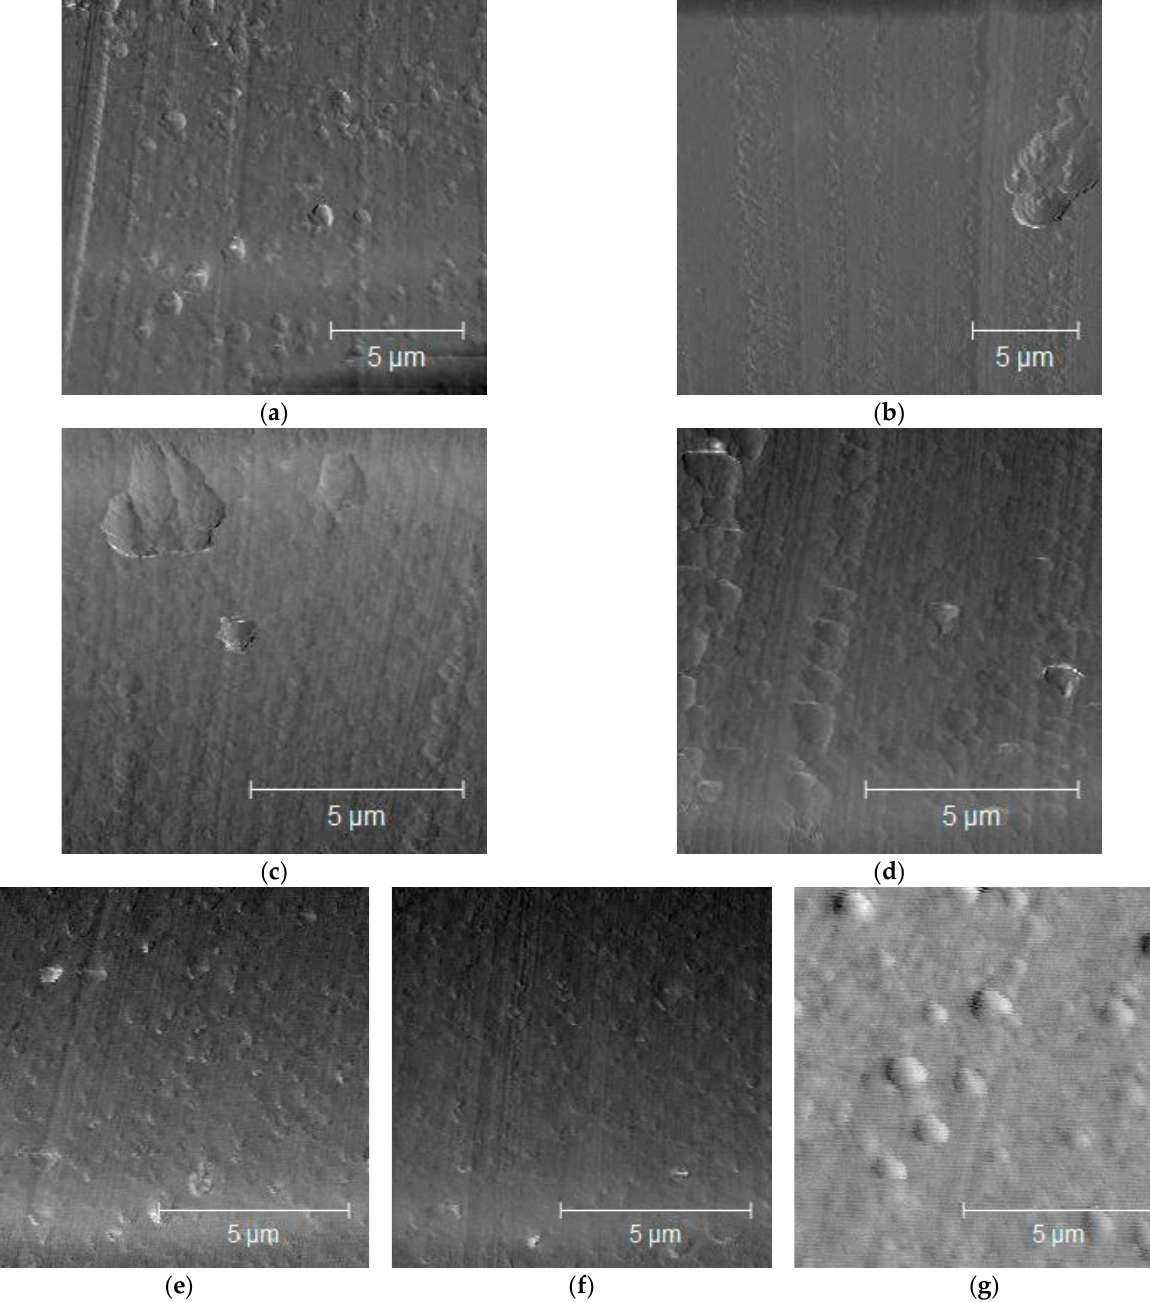
Figure 2. Morphologies of PC/PS/nano-fillers: ( a ) PC/PS; ( b ) PC/PS/clay (90/9.95/0.05); ( c ) PC/PS/ clay (90/9.9/0.1); ( d ) PC/PS/clay (90/9.7/0.3); ( e ) PC/PS/silica (90/9.95/0.05); ( f ) PC/PS/silica (90/9.9/0.1); ( g ) PC/PS/silica